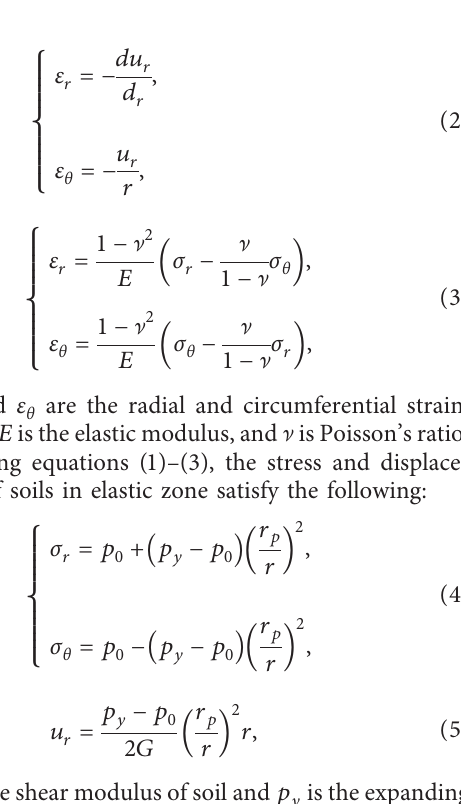
Figure 1: Mechanical model of cylindrical hole